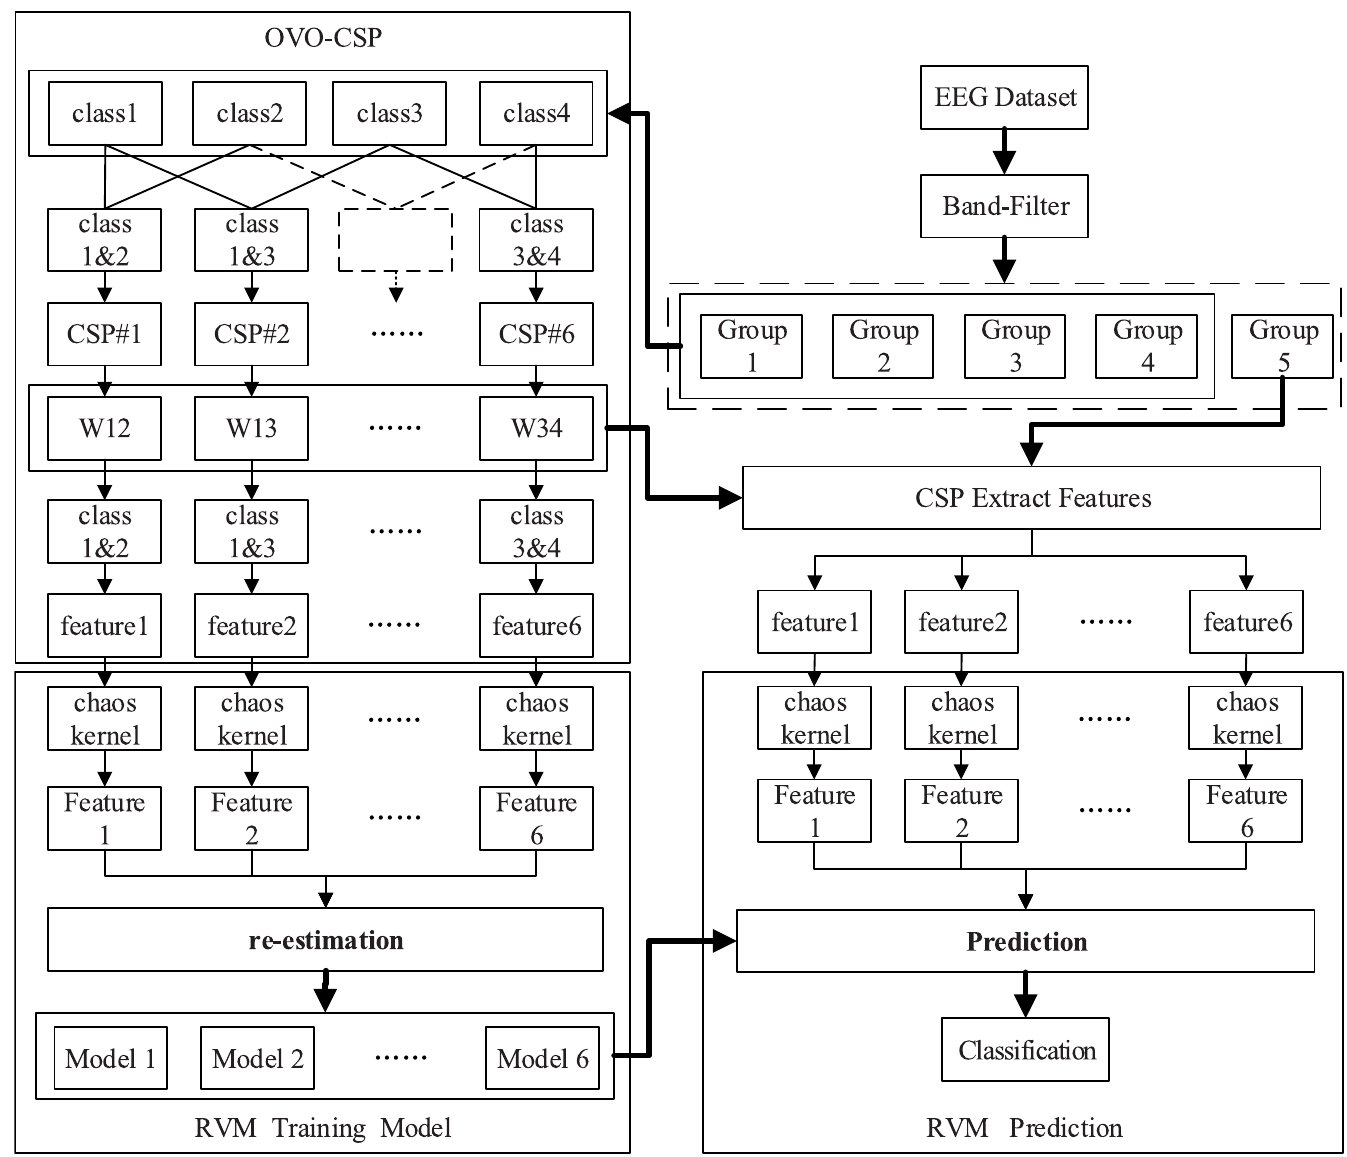
Fig 8. The framework of four-class MI classification based on OVO-CSP and chaos kernel RVM.